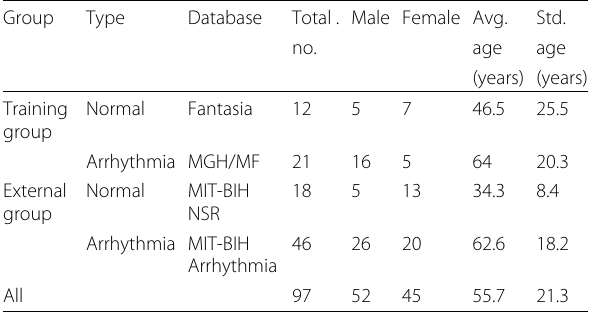
Table 1 Dataset summary